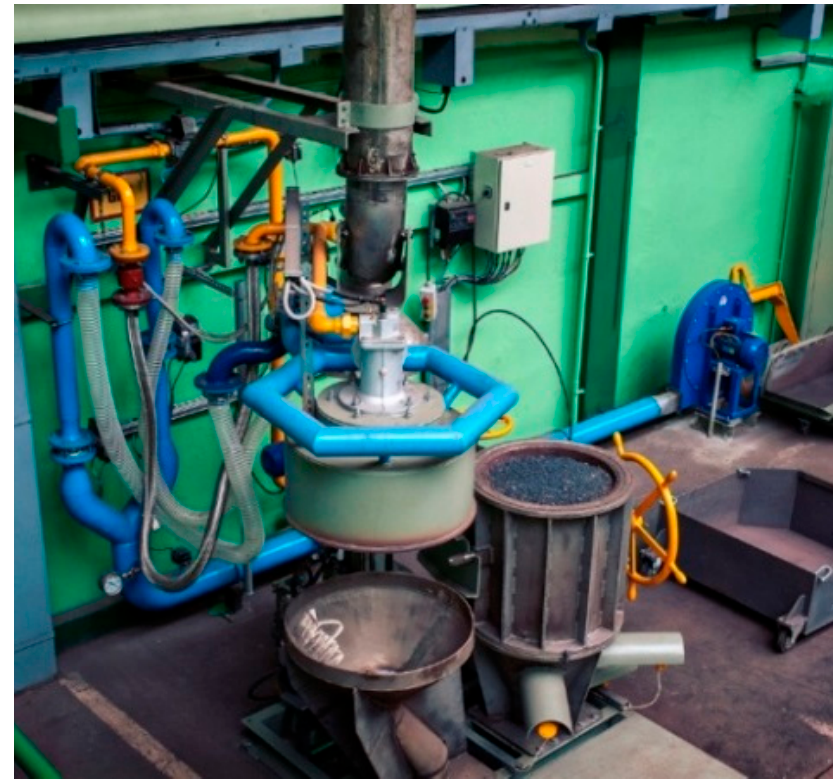
Figure 2. View of semi-industrial-scale installation for sintering of iron ores.